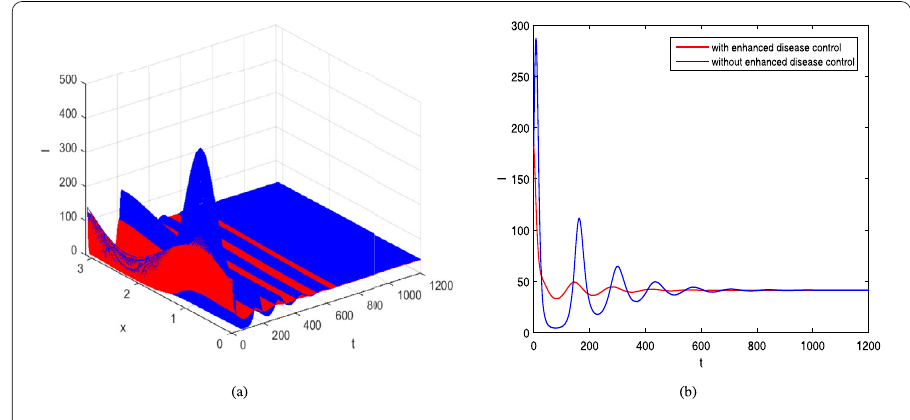
Figure 3 Simulations for numbers of the infected individuals I ( x , t ) of system (2.1) with threshold I c control (blue) and without threshold I c control (red) in the case 1 < R 0 < R c . ( a ) I ( x , t ) at x ∈ [0, π ]; ( b ) I ( x , t ) at x = π